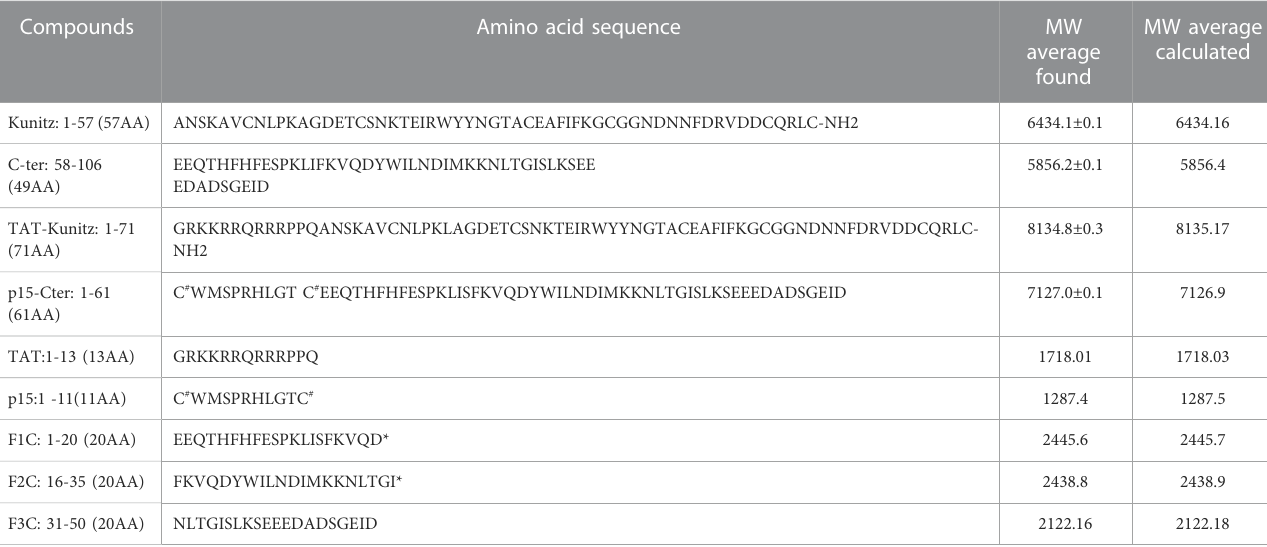
TABLE1SynthesisofAmblyomin-Xdomainsandrelatedpeptidesusedinthestudy.AminoacidsequenceandMolecularweight(average) byESImassspectrometry. *: amidation; C # : the 2 cysteines are connected by a disul fi de bond. Compounds Amino acid sequence